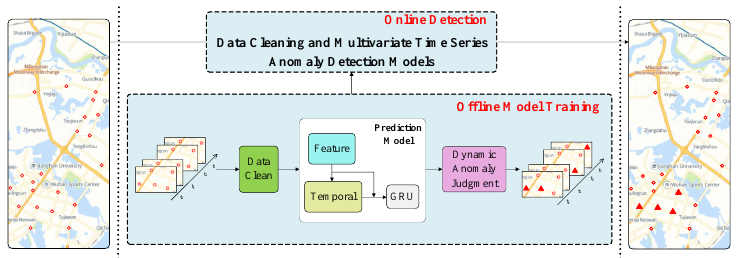
Figure 6. An example of offline model training and online detection process on traffic